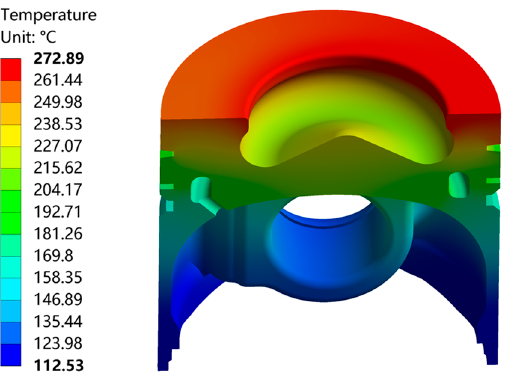
Figure 9. Temperature field of conventional Al-Si piston under 50% load.